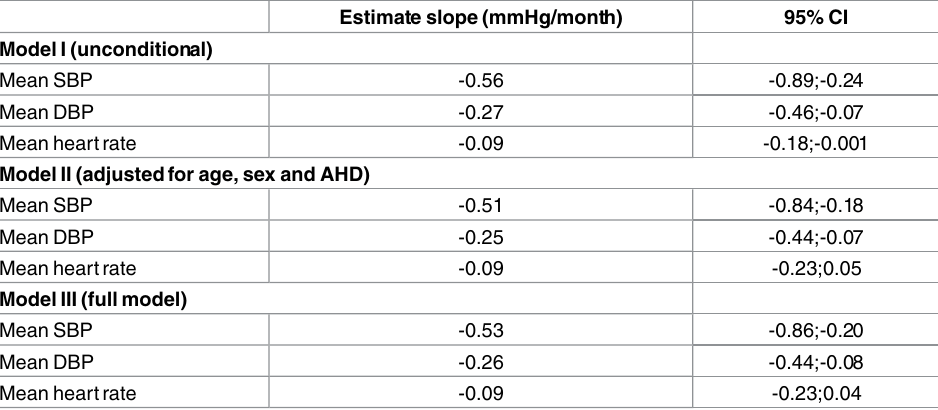
Table 2. Changein home bloodpressureover